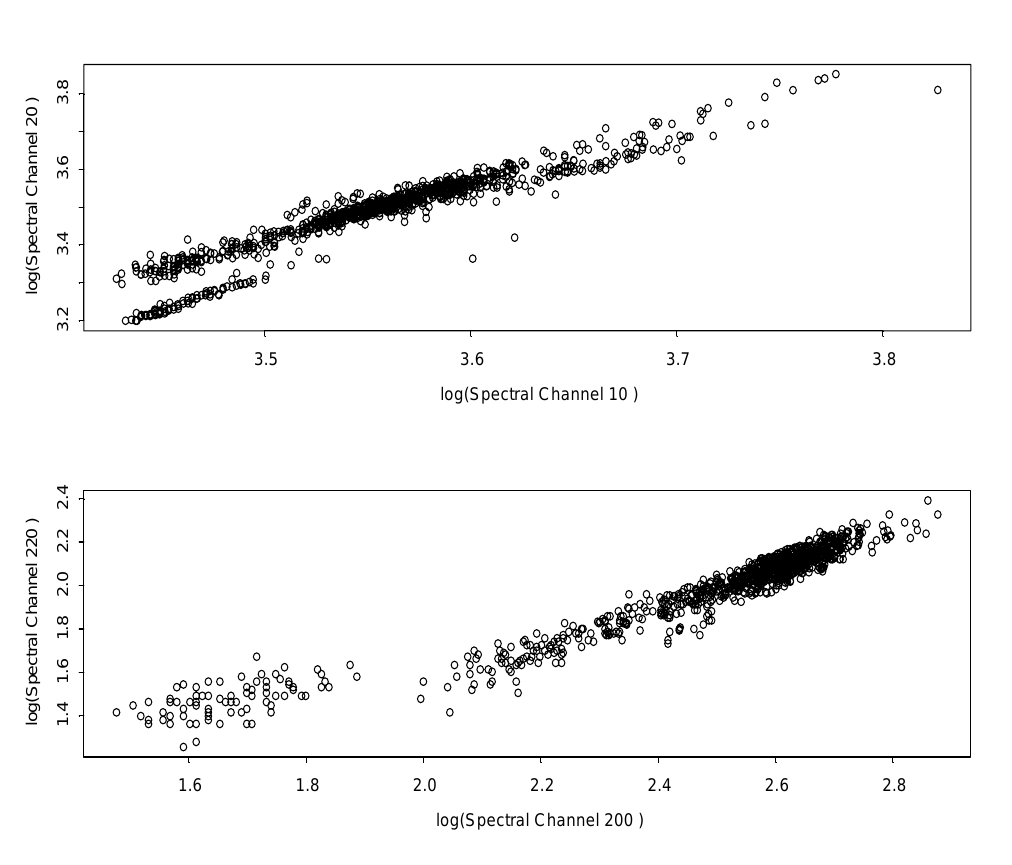
Figure 4. Scatter plot of two sets of log-transformed (log base 10) spectral channel pairs, each from the same 1000 randomly-selected pixels from scene